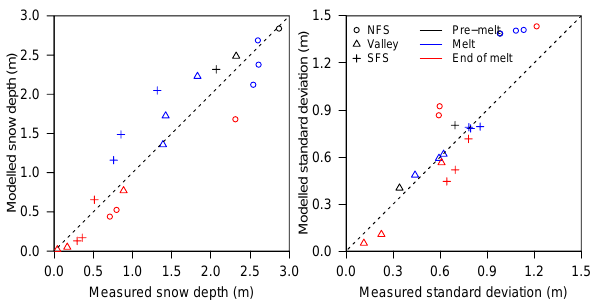
Figure 7. Modelled vs. measured average snow depths and standard deviation of snow depth on the northeast facing slope (NFS), the valley bottom and the southwest-facing slope (SFS) before, during and at the end of the melt season. Modelled standard deviation is extrapolated to 4m